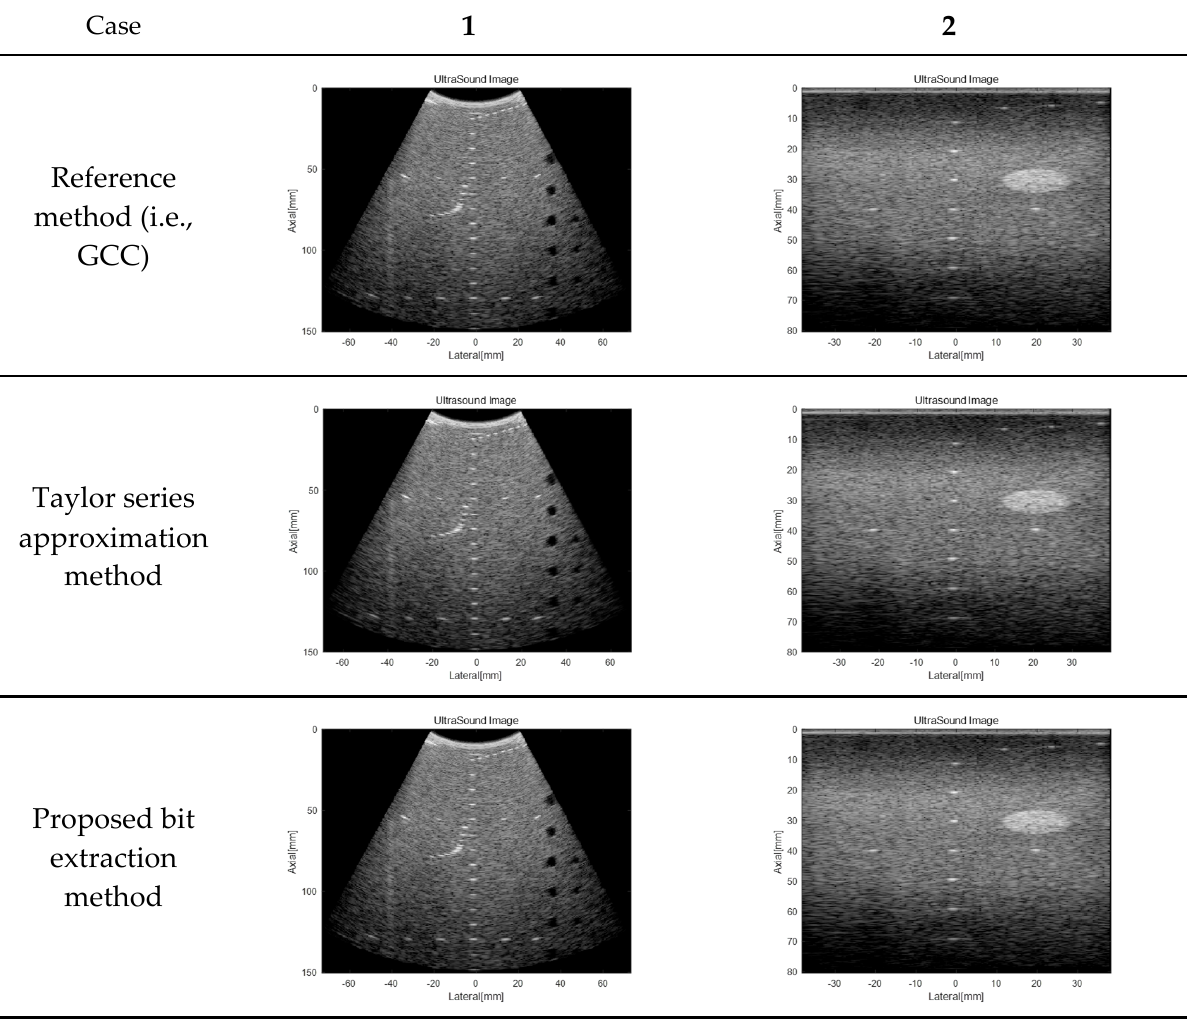
Figure 4. Comparison of reconstructed images of two phantom data pieces from the reference, Taylor series approximation and proposed bit extraction methods.